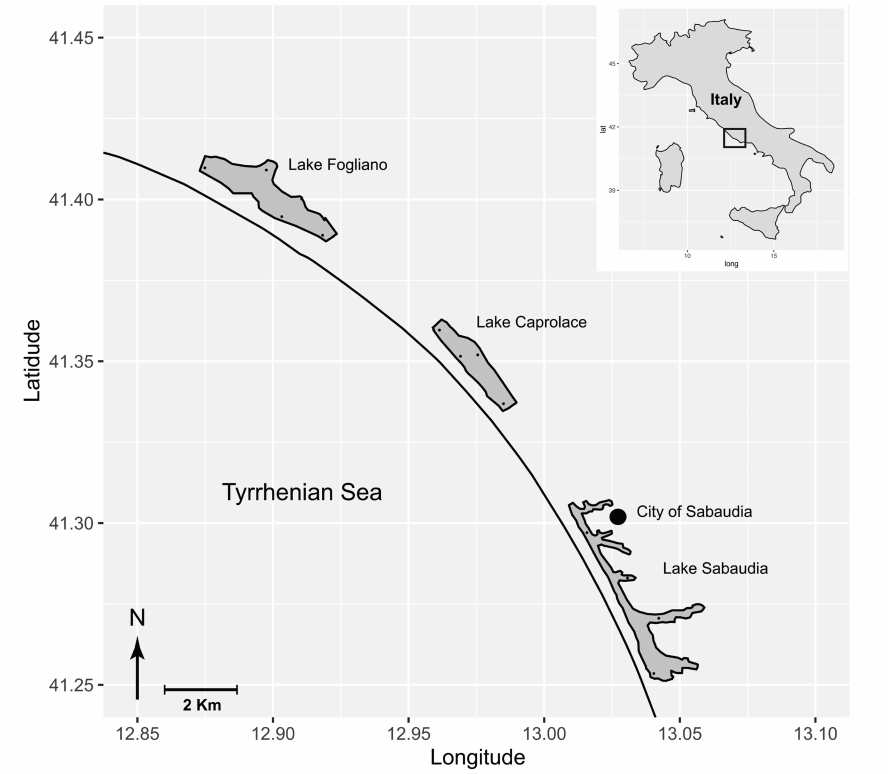
Figure 1. Map of the sampling area. The map shows the costal lakes of Caprolace (LP), Fogliano (IP) and Sabaudia (HP) located on the Tyrrhenian coast of central Italy (42 ◦ 28 (cid:48) 00” North–12 ◦ 51 (cid:48) 00”